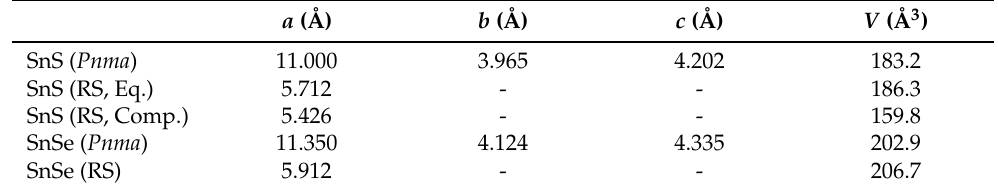
Table 1. Optimised lattice parameters of the five structures examined in this work. Eq.—equilibrium;